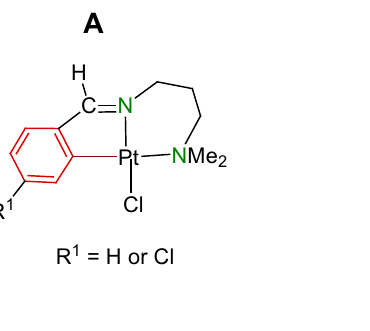
Figure 1. A selection of cyclometallated Pt(II) complexes with a σ (Pt-C Ph ) bond and potent cytotoxic activity reported recently. For illustrative purposes IC 50 values (in µM) for A – C in a specific cancer cell line are given: in HCT-116 colon cell line for A compounds: IC 50 = 28 ± 2.4 µM ( R 1 = H) and 18 ± 1.9 µM ( R 1 = Cl); for type B , IC 50 in the range 0.95 µM–7.7 µM ( IC 50 for cisplatin = 40 ± 4.4 µM). Compound C was tested in the A549 breast cancer cell line, IC 50 = 4.60 µM (for cisplatin = 8.0 µM)